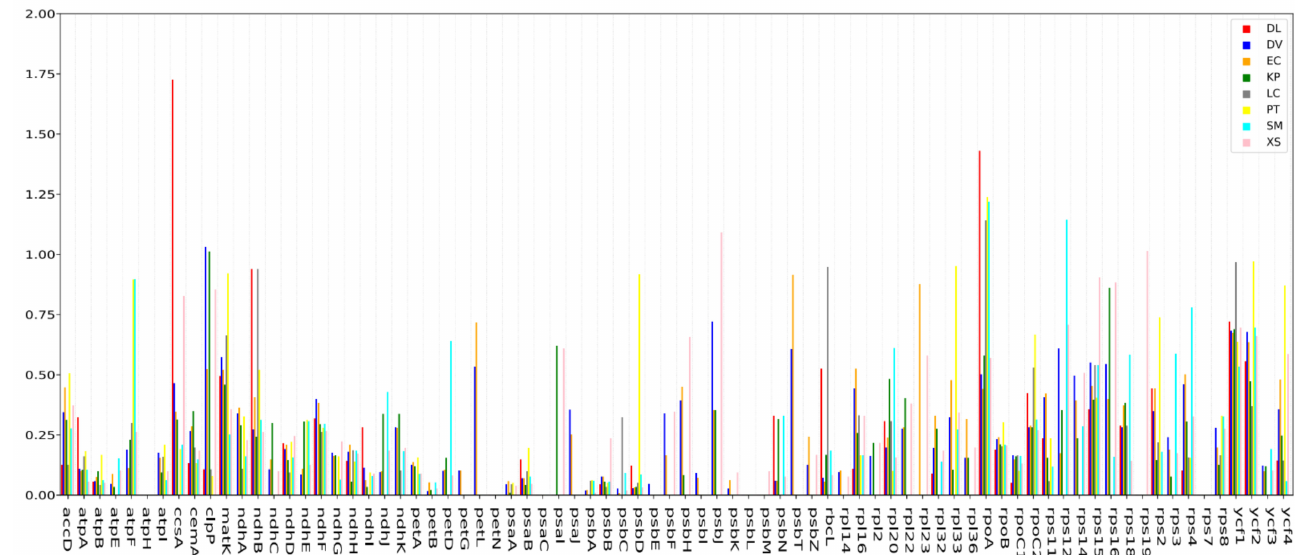
Figure 6. The Ka/Ks ratios of 78 protein-coding genes of the N. lappaceum chloroplast genome versus eight closely related species of Sapindaceae.